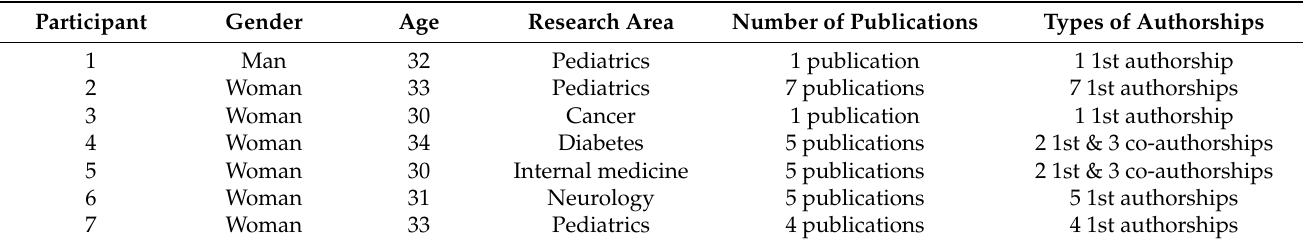
Table 1. Study participants interviewed on facilitators and barriers experienced when writing their first article for